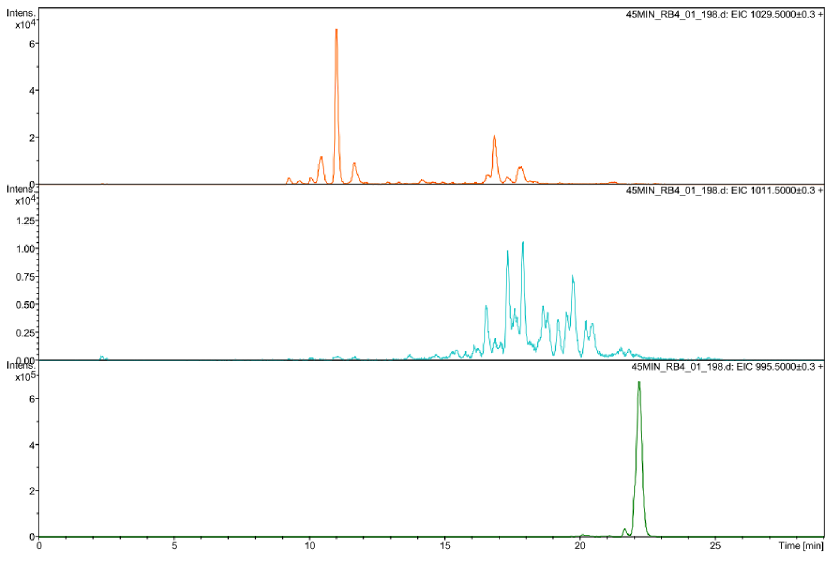
Fig 1. LC-MS chromatograph of MCLR after 45 min of UV/H 2 O 2